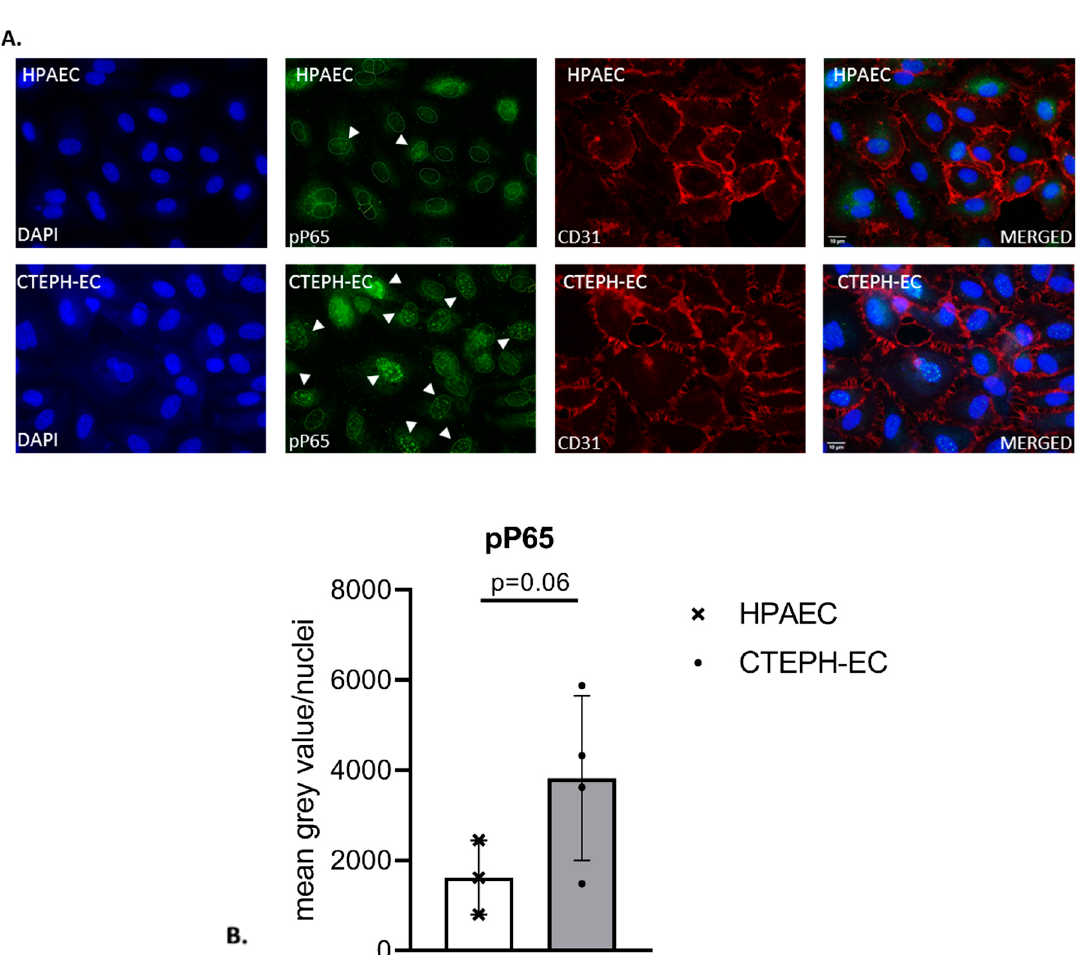
Figure 2. Fluorescence staining of phospho-P65 in cultured ECs. ( A ) HPAECs (top) and CTEPH-ECs (bottom) were stained for endothelial marker CD31/PECAM (red) and phospho-NF- κ B-P65 (pP65; green). Both ECs showed the presence of CD31/PECAM and nuclear pP65 staining (indicated by the white arrows). Nuclei were counterstained with DAPI; scale bar, 10 μ m. ( B ) The presence of nuclear pP65 was quantified in both CTEPH-ECs and HPAECs. CTEPH-ECs showed a 2.4-fold higher presence of nuclear pP65 compared to control cells ( p = 0.06) (unpaired t -test); CTEPH-ECs, n = 4 donors; HPAECs, n = 3 donors. Data are expressed as mean ± SD.